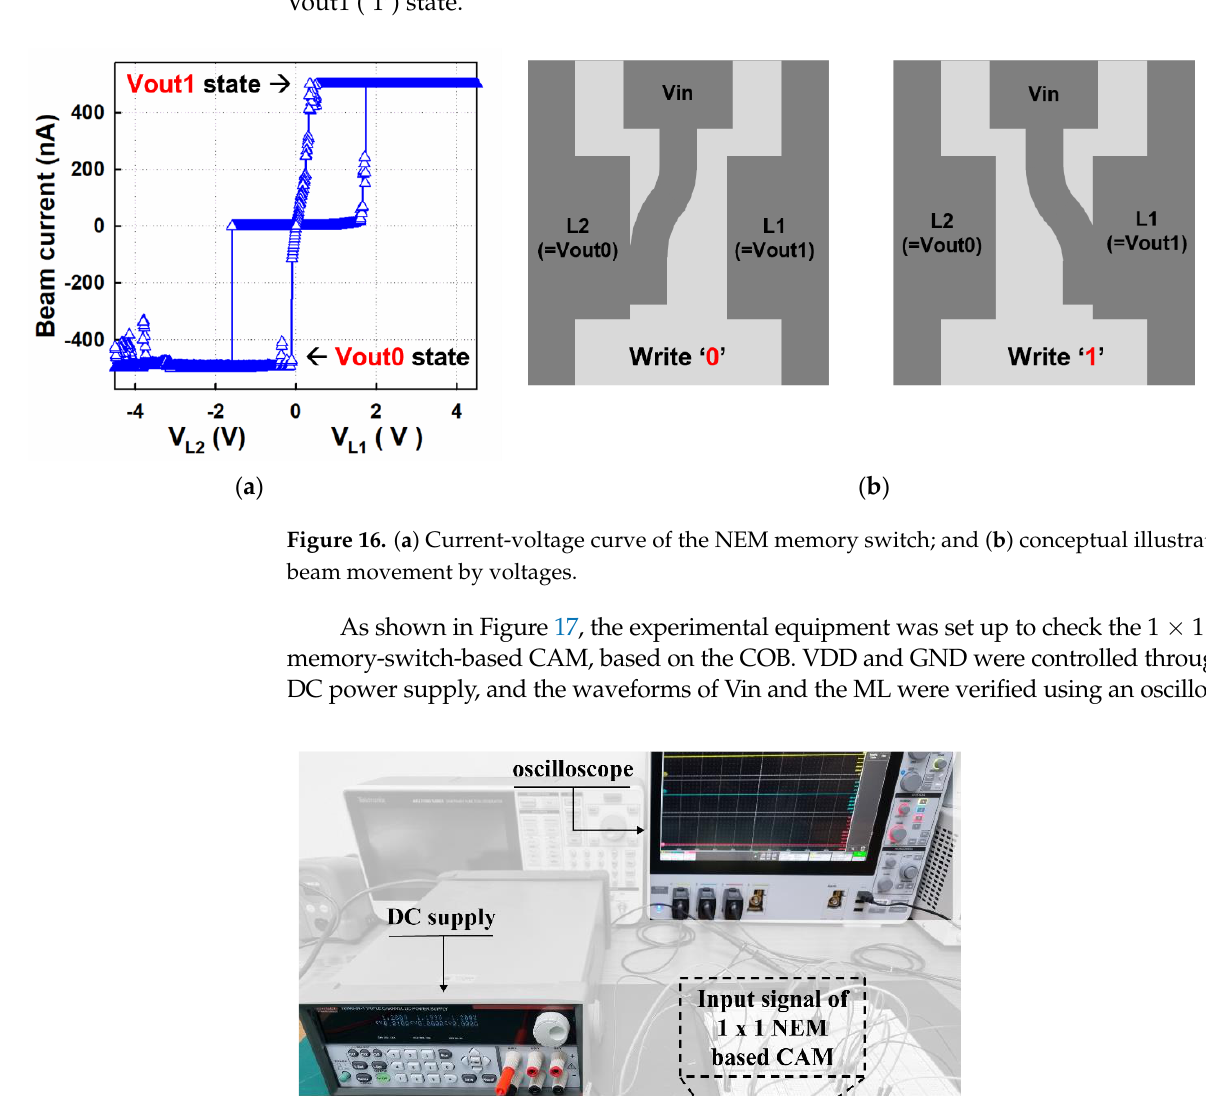
13 of 16 Figure 15. Die photo and 1 × 1 NEM-based CAM for movable-beam operation verification. Figure 16a shows the switching behavior of V L2 state (Vin = Vout0) and V L1 state (Vin = Vout1) of a NEM memory switch. Possible micro-welding effects in NEM memory switches are suppressed by limiting the maximum current level to 500 nA during meas- urement [26]. To check whether the movable beam can be in contact with the two states normally, an experiment was conducted with the additional PAD mentioned above. A